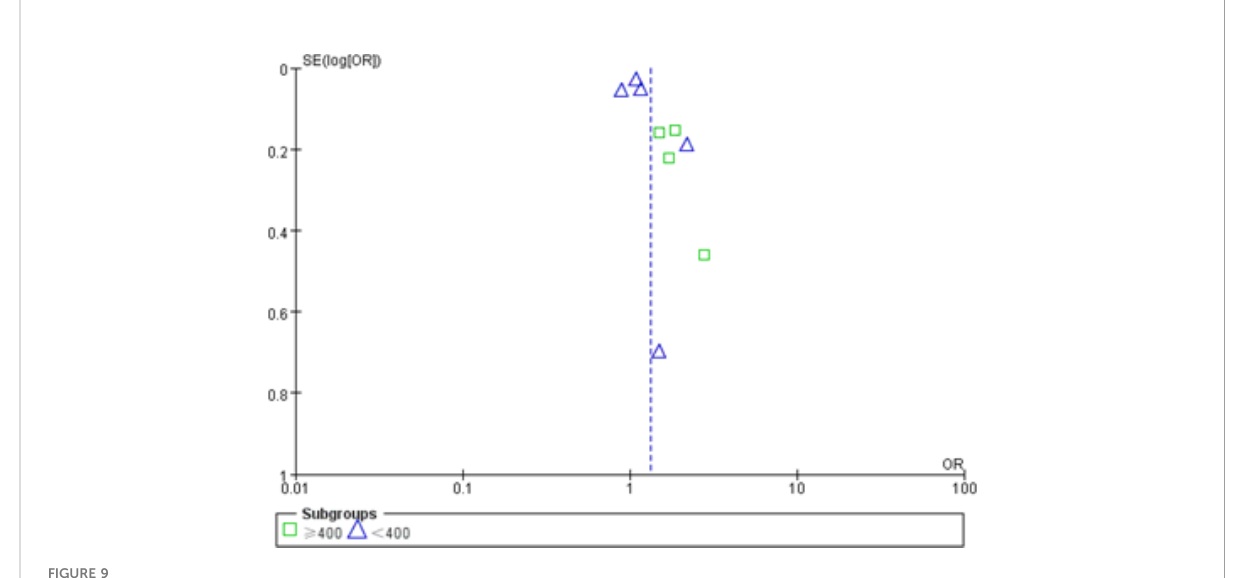
FIGURE 9 Funnel plot of publication bias of NLR with DCI